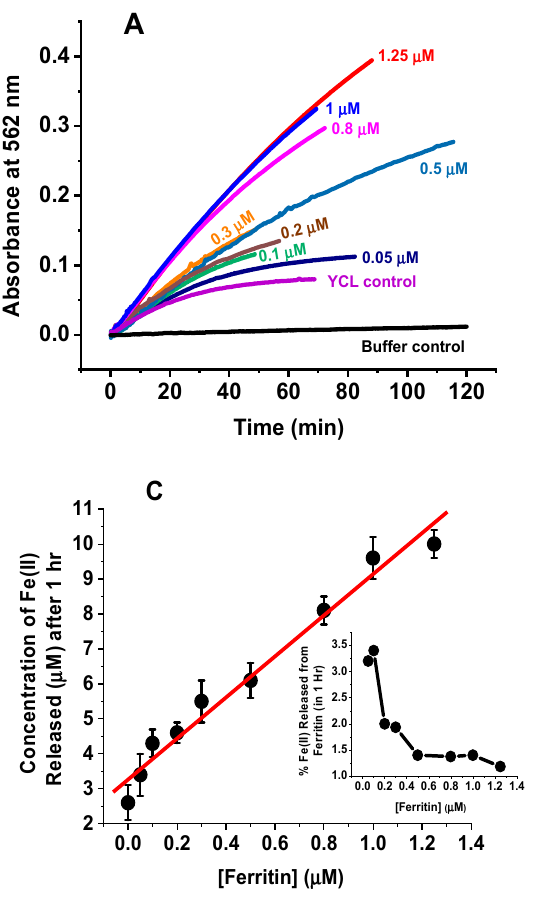
Figure 1. Iron mobilization kinetics from ferritin in yeast cell lysate (YCL). ( A ) Absorbance change of the (Fe 2+ –(ferrozine) 3 ) complex following the exogenous addition of ferritin and NADPH to yeast cell lysate. ( B ) Rates of iron release as a function of ferritin concentration. ( C ) Concentration of released iron, in one hour, as a function of ferritin, with % Fe(II) released shown in the inset. Conditions: 555 µ L YCL, 1.5 mM NADPH, reaction volume 1 or 2.3 mL, ferritin concentration is indicated next to each kinetic trace, 3 mM ferrozine, 20 mM MOPS, pH 7.4. The red lines are first-order fits to the data, and the ferritin sample used here is recombinant human heteropolymer ferritin H 23 L 1 loaded with 500 Fe/shell.